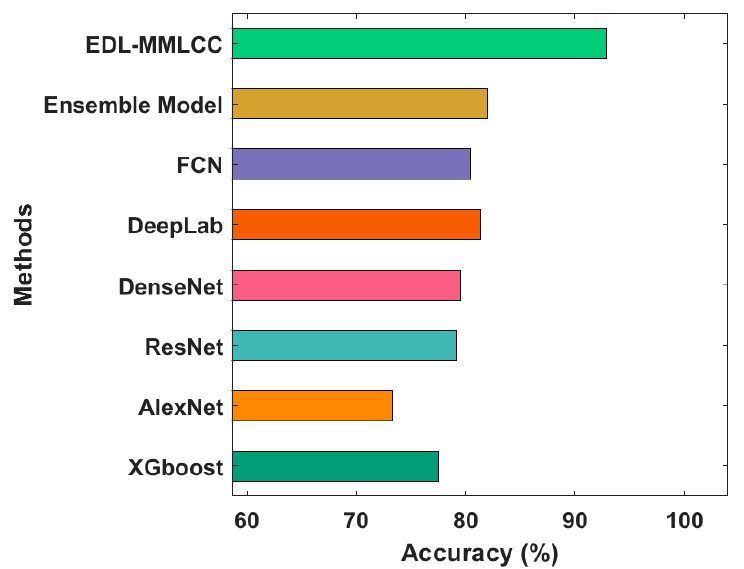
Figure 11. Accuracy analysis of EDL-MMLCC model with recent approaches.